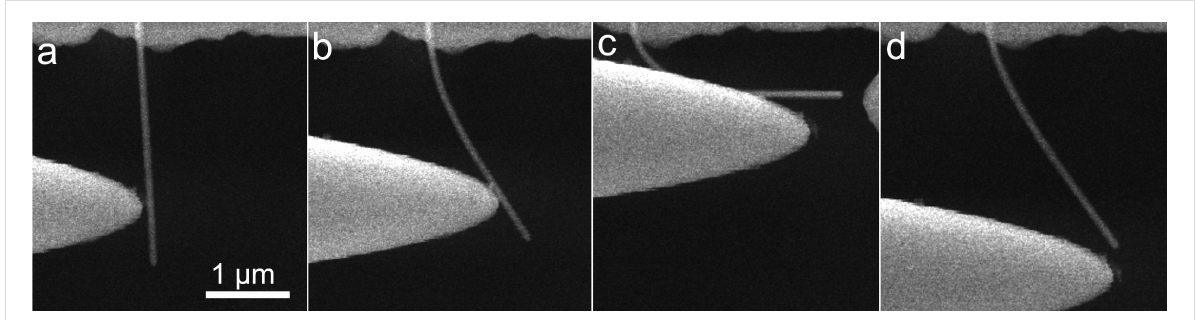
6.8 GPa for Ag and Au NWs, respectively, which is close to the theoretical strength of this materials. The abrupt transition can be attributed to two factors: the inner structure of the pentag- onal NWs and its free surface. The five twin boundaries dividing the structure can hinder the propagation of disloca- tions and prevent a smooth onset of plastic deformation under a cantilevered beam bending configuration. Therefore, the accu- mulation of dislocations at the twin boundaries leads to the brittle fracture-like onset of plastic deformation. The free sur- face of the NW facilitates the nucleation of defects, such as dislocations in an otherwise practically defect-free pentagonal NW structure. Additional preliminary experiments with alumina-coated Ag NWs showed that coating can increase the bending strength of the